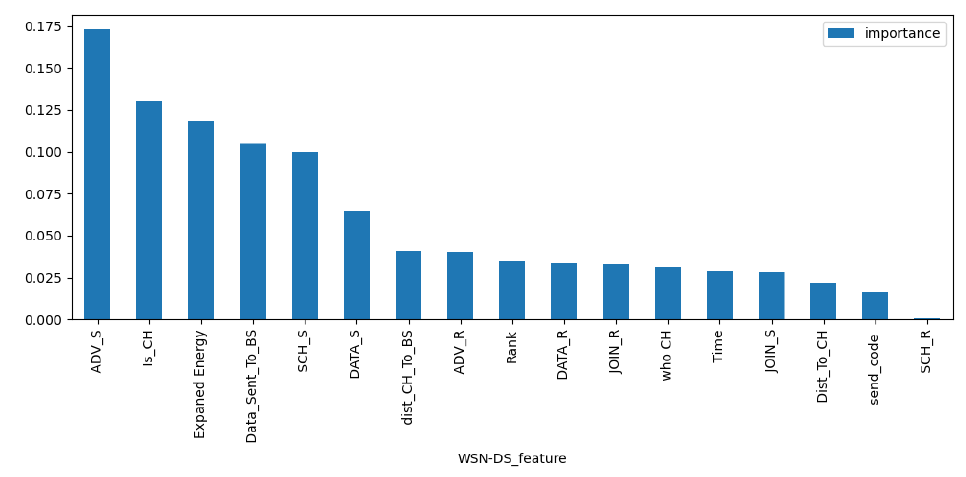
Figure 7. Feature importance of